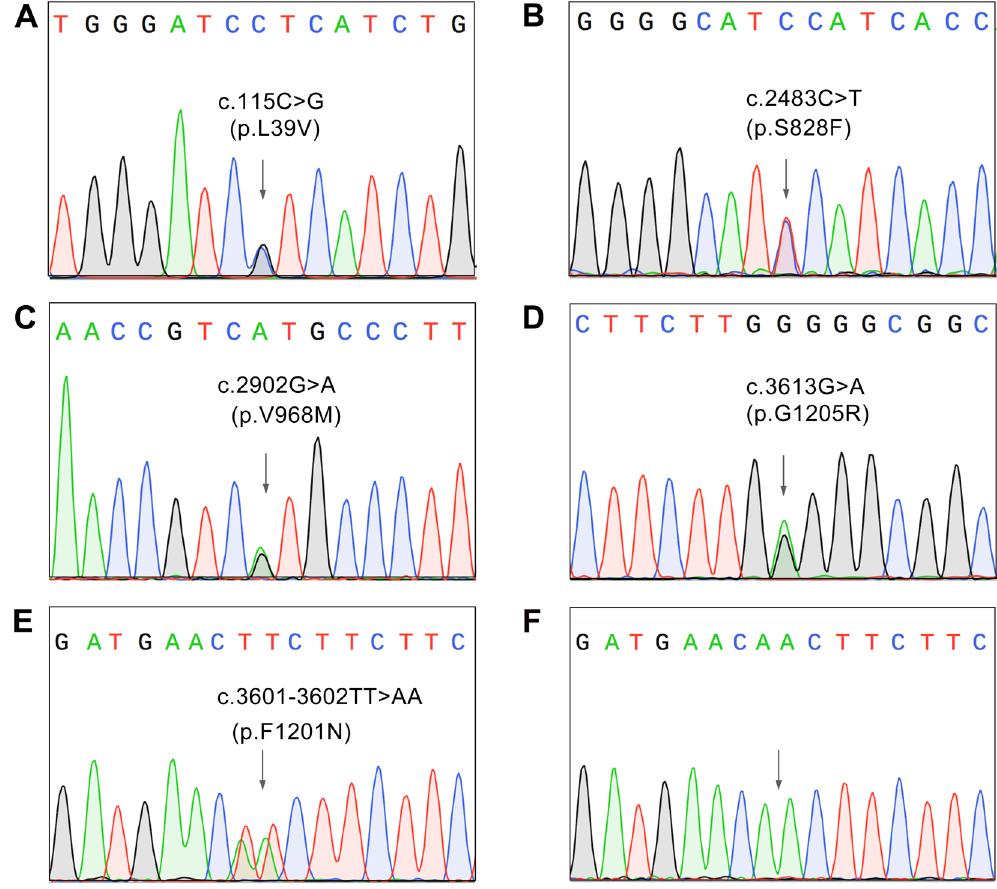
Figure 2. Confirmation sequencing of the variants detected in the ABCA3 gene, by using a TaqMan probe. ( A,B,C,D) the variants c.115 C > G (p.L39V), c.2483 C > T (p.S828F), c.2902 G > A (p.V968M) and